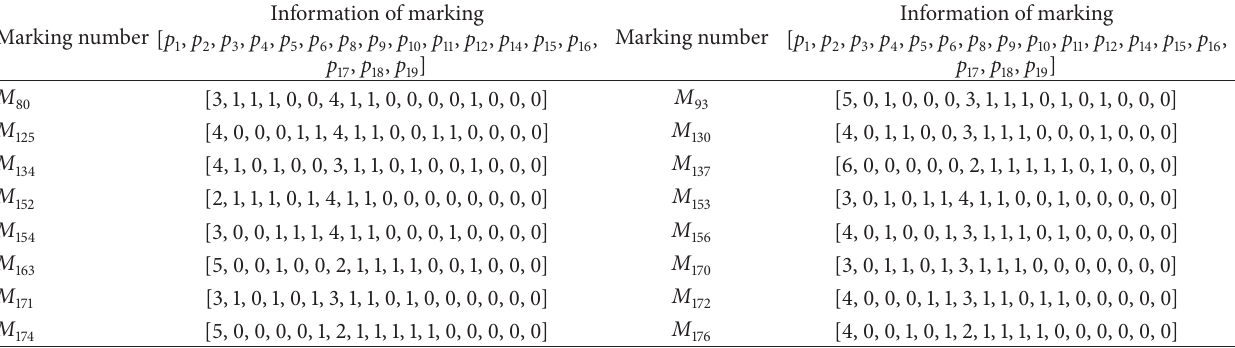
Table 2: The detailed information of dead markings.